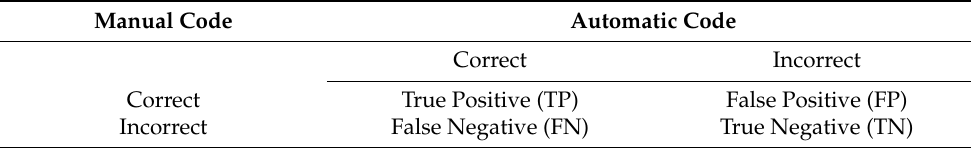
Table 3. Confusion